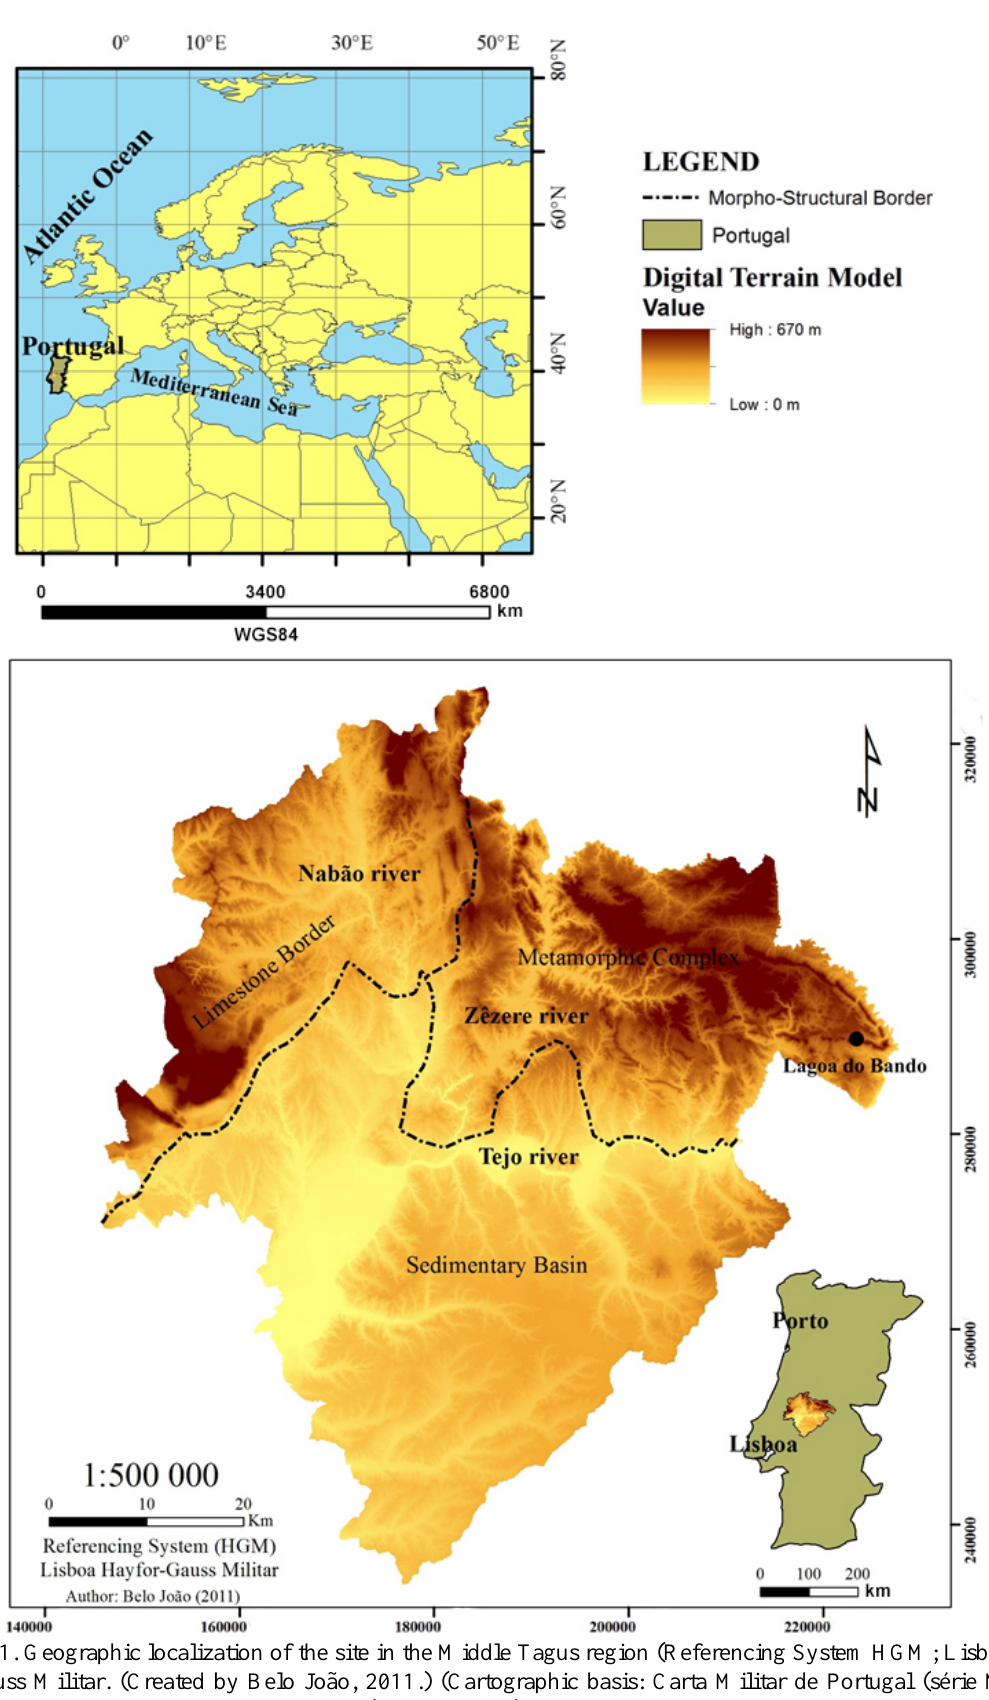
Figure 1. Geographic localization of the site in the Middle Tagus region (Referencing System HGM; Lisboa Hay for-Gauss Militar. (Created by Belo João, 2011.) (Cartographic basis: Carta Militar de Portugal (série M888), 1:25000, Instituto Geográfico do Exército, (digital format); Carta Geológica de Portugal, 1:500,000, 5a Edição, S.G.P., (digital format).) Referencing system (HGM) Lisboa Hayfor-Gauss